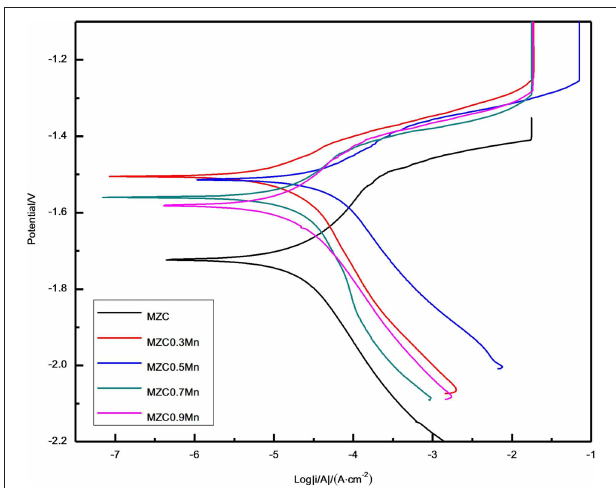
FIGURE 10 | The polarization curve of as-extruded MZC, MZC0.3Mn, MZC0.5Mn, MZC0.7Mn, and MZC0.9Mn alloys.